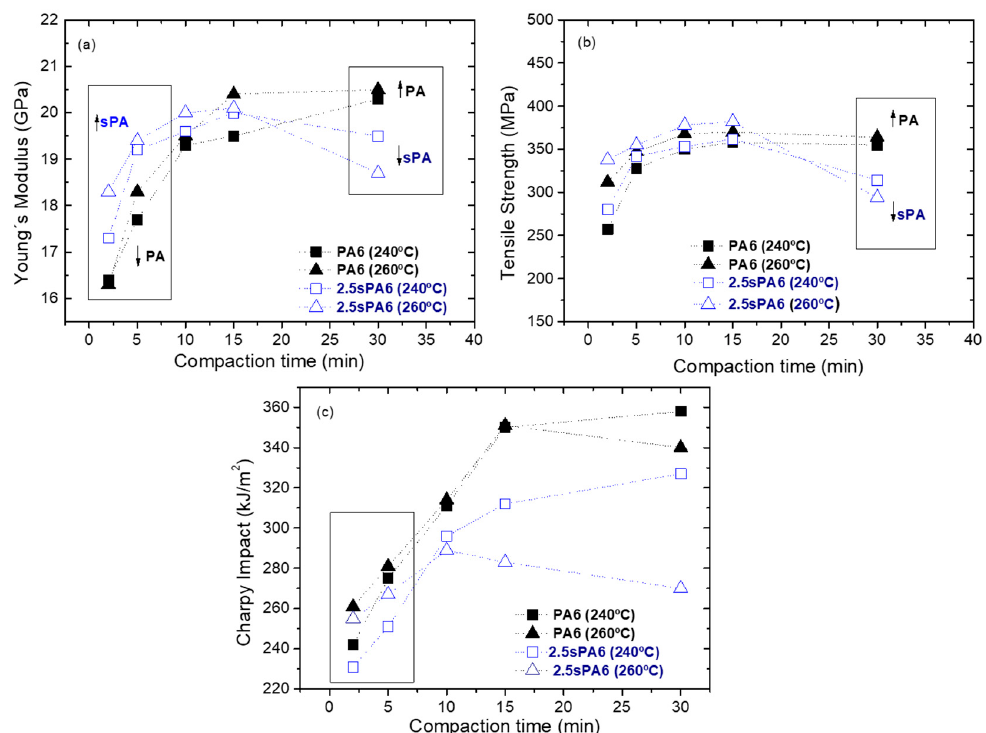
Figure 12. Results obtained from the characterization of composites of PA6 and 2.5sPA6 by film stacking at 240 and 260 °C: ( a )Young’s modulus, ( b ) tensile stress and ( c ) Charpy impact test.